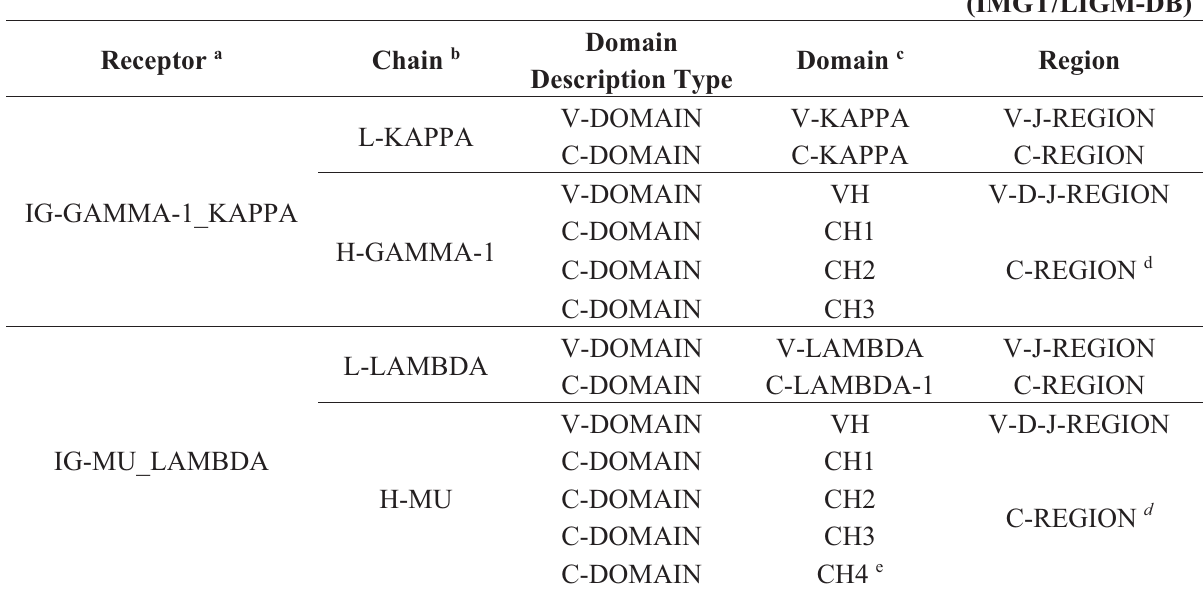
Table 1. Immunoglobulin ( IG) receptor, chain and domain structure labels and correspondence with sequence